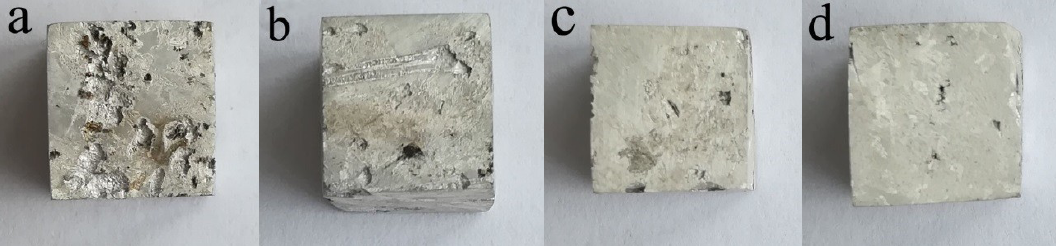
Figure 9. Macroscopic corrosion morphology of AZ91–xSm magnesium alloys treated with ultrasound, where x = ( a ) 0 wt %; ( b ) 0.5 wt %; ( c ) 1 wt %; ( d ) 1.5 wt %.